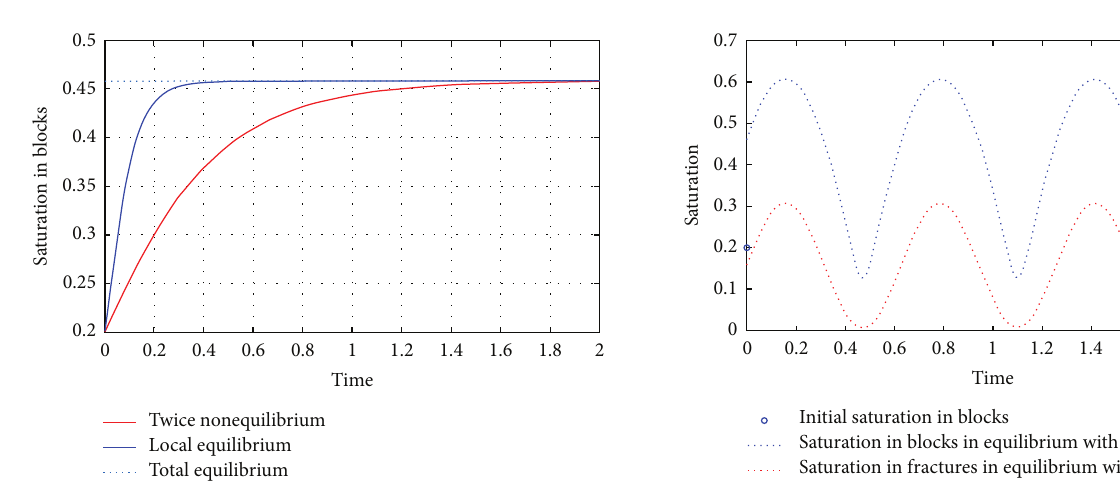
Figure 4: Evolution in time of the saturation in blocks from the initial nonequilibrium state; at constant saturation in fractures.